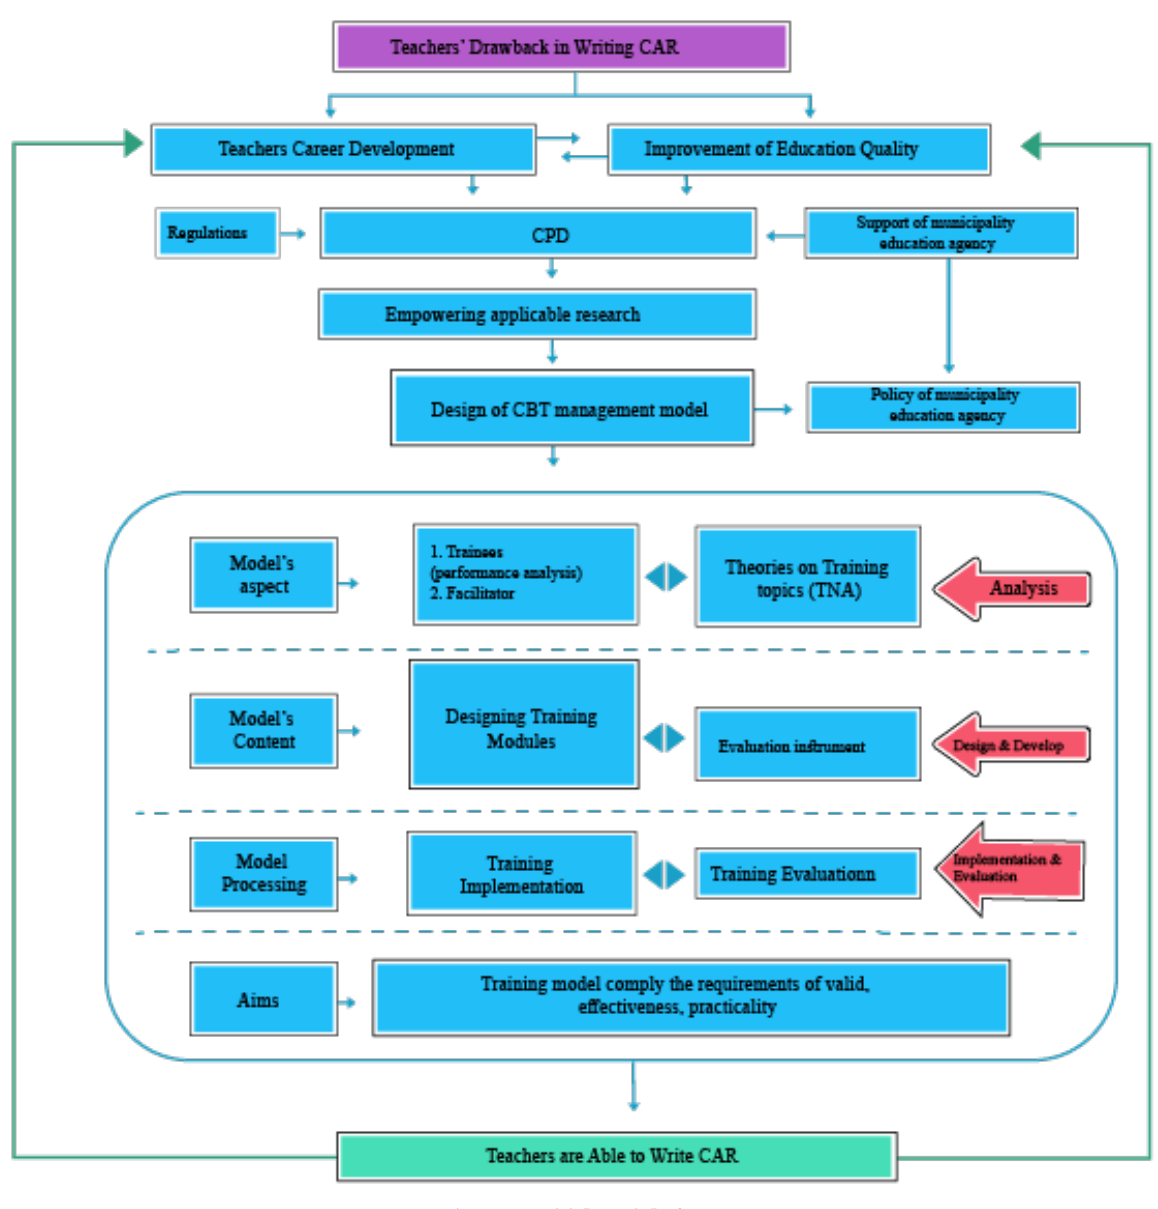
Figure 2. Initial Model of